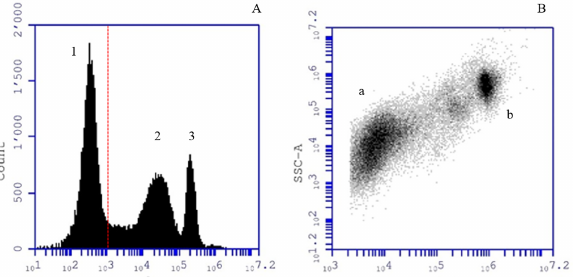
Fig 5. Flow-cytometry identification of phototrophic populations in the chemocline of Lake Cadagno. Lake Cadagnosample at 12.2 meters depth, 12 July 2016. (A) Histogram count versus red fluorescence (logarithmic FL3-A). Red fluorescence (FL3-A > 1’100)indicatesthe presenceof chlorophyll-pigmentedcells. (B) Scatter plot SSC versus FSC highlights two photosynthetic bacterial populations. Population a has a similar FCM-scatter signatureas GSB Chlorobium spp., whereaspopulation b has a similar FCM-scatter signature as PSB C . okenii as measuredfrom pure cultures.